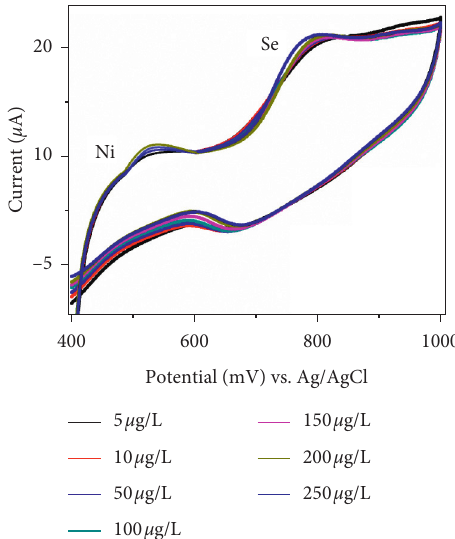
Figure 4: Comparative voltammograms of a solution containing Se (IV) and Ni (II) for different concentrations in 0.1 M PBS and 5 mM Fe(CN) 6 at a scan rate of 100mV/s by Mn 3 O 4 -Cn electrode at 25 ° C in the range of 400 to